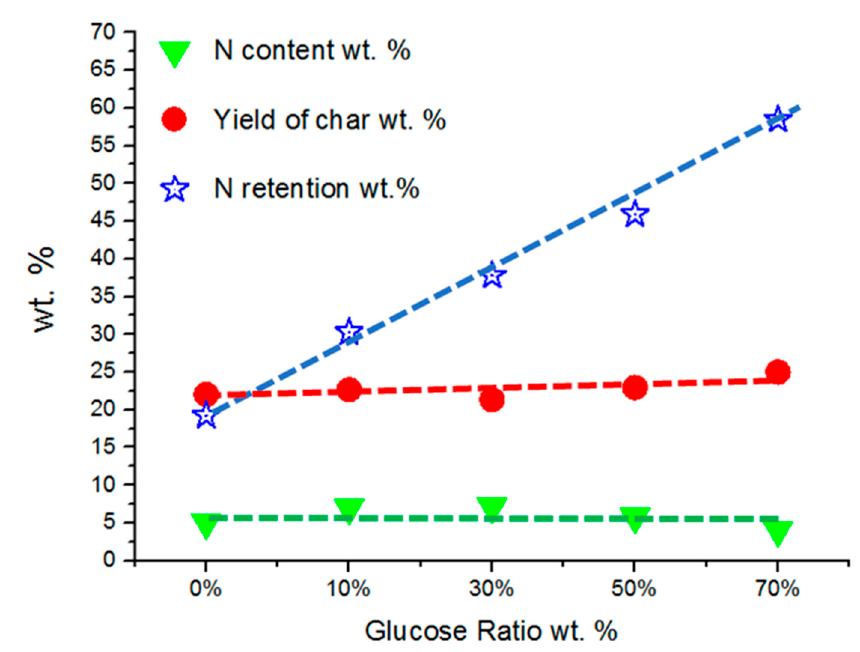
Figure 2. Nitrogen content, char yields and nitrogen retention as a function of glucose percentage in feedstock.